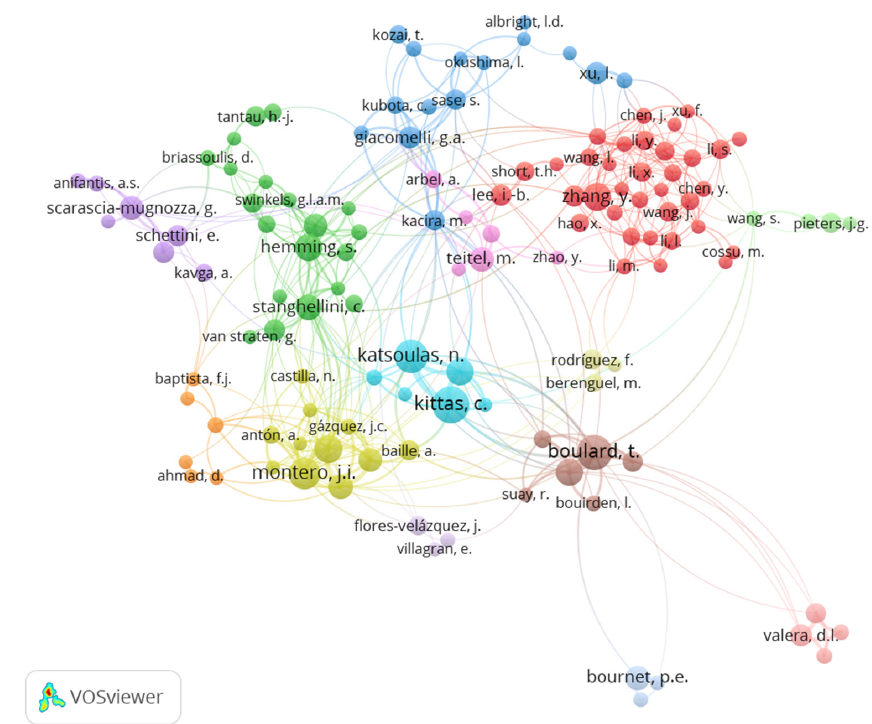
Figure 6. Co-operative network of the key authors.